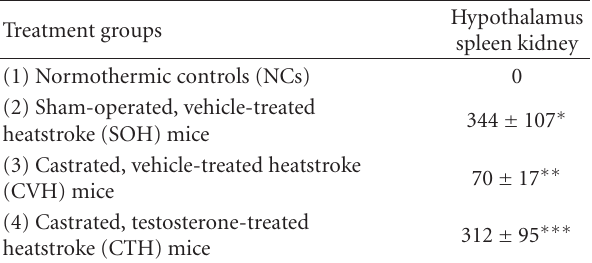
Table 3: Mean ( ± SEM) of neuronal damage score values in hypothalamus for di ff erent groups of